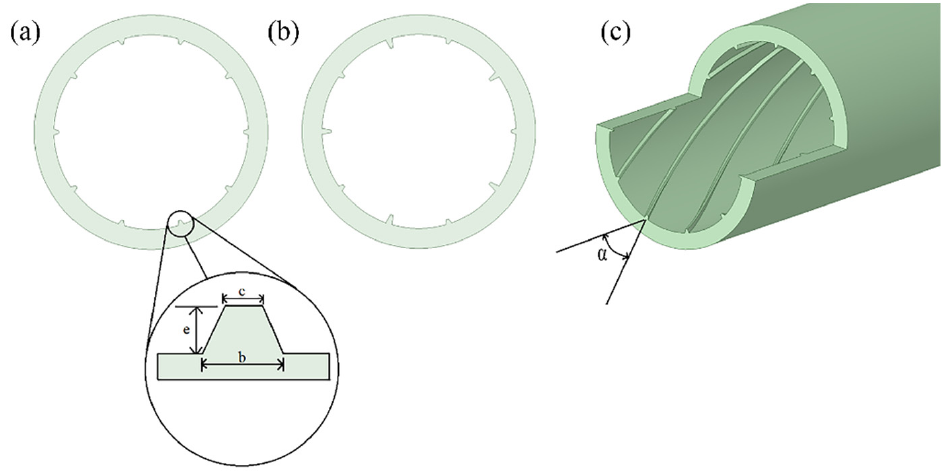
Figure 1. Helically finned tube geometry ( a ); Equal fin height tube cross-section ( b ); Alternating fin height tube cross-section ( c ); and, 3D tube geometry.